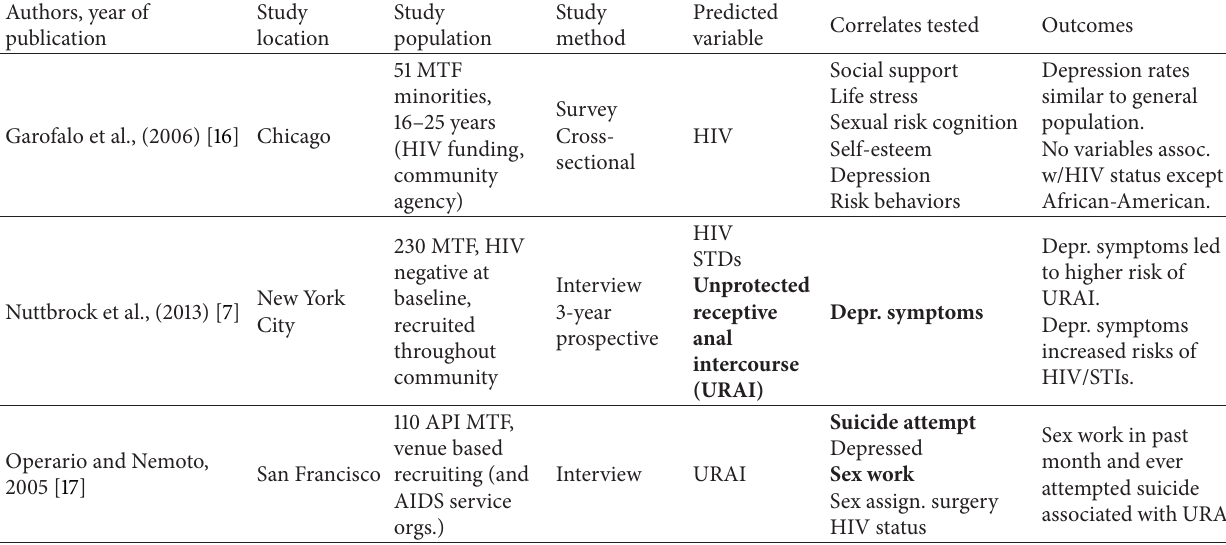
Table 2: Depression as a factor predicting health-related